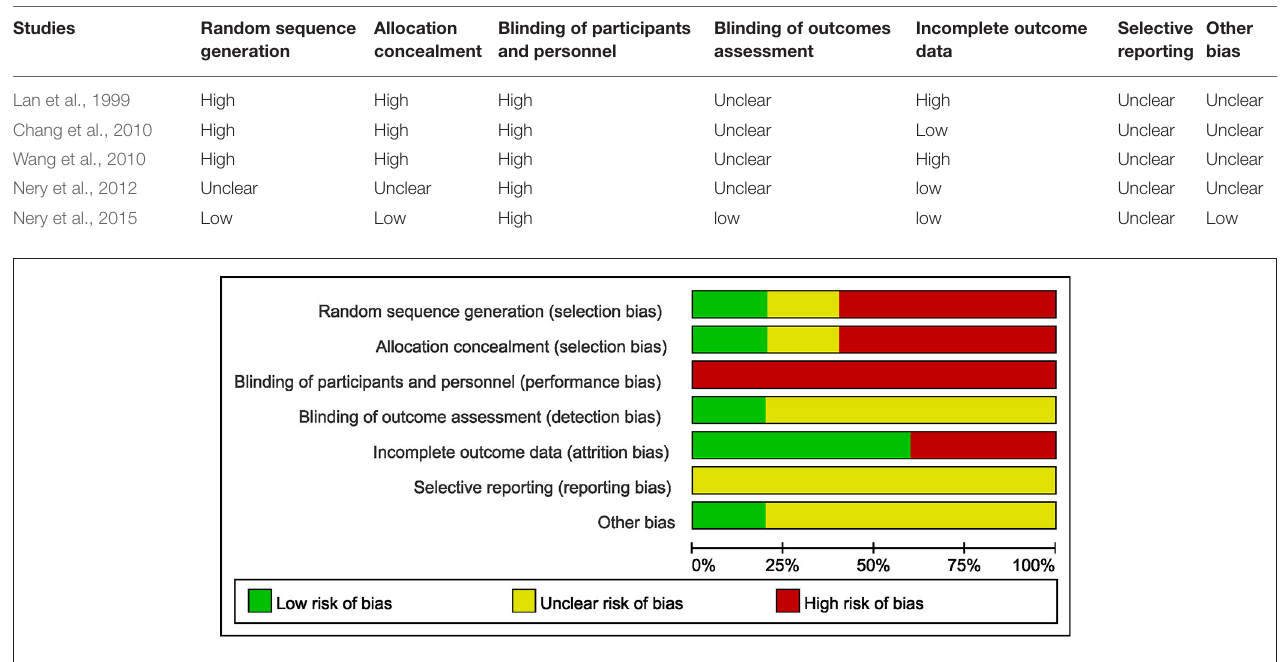
FIGURE 2 | Risk of bias graph.